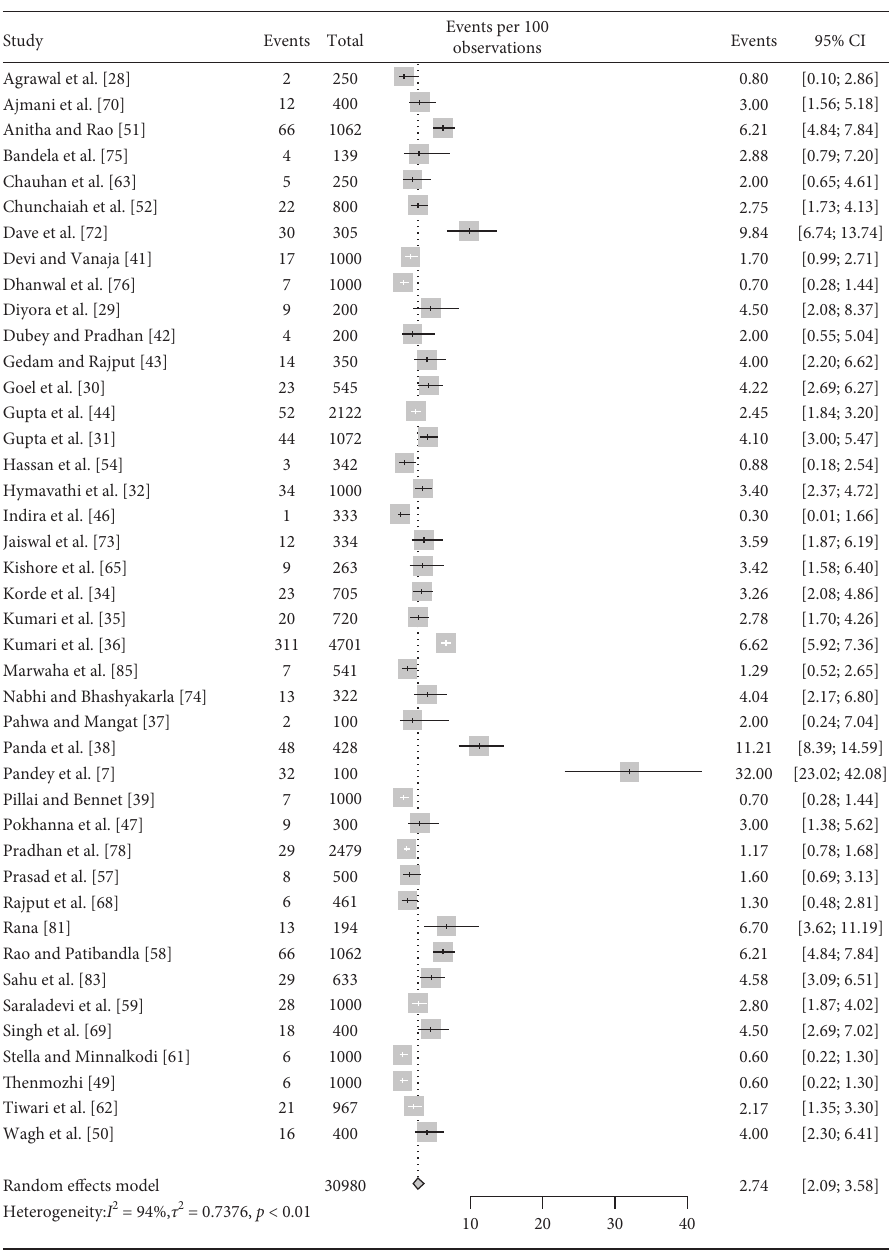
Figure 4: Forest plot showing pooled estimate for prevalence of overt